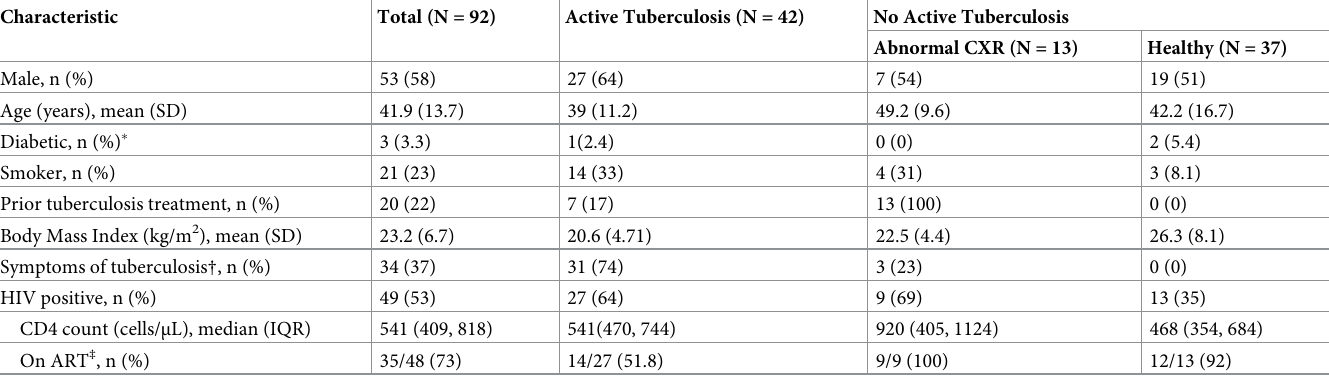
Table 2. Demographic and clinical characteristics of study population (N =